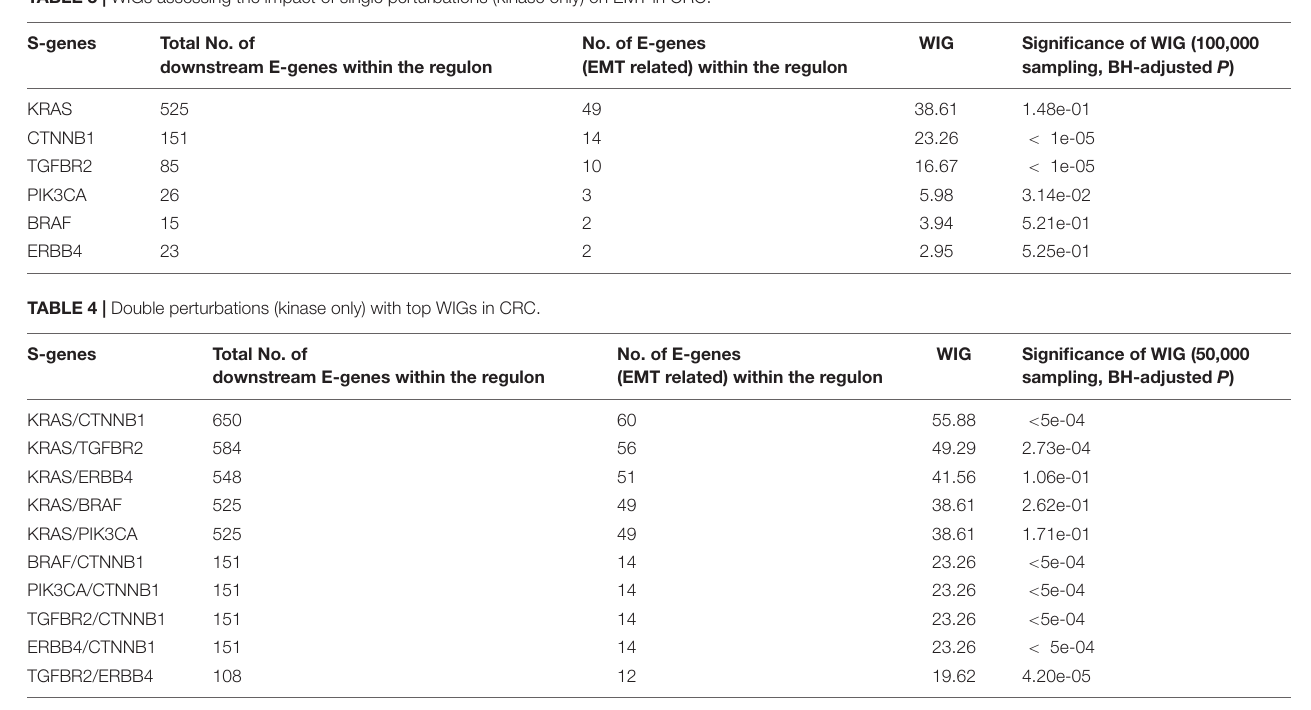
TABLE 3 | WIGs assessing the impact of single perturbations (kinase only) on EMT in CRC. S-genes Total No. of downstream E-genes within the regulon